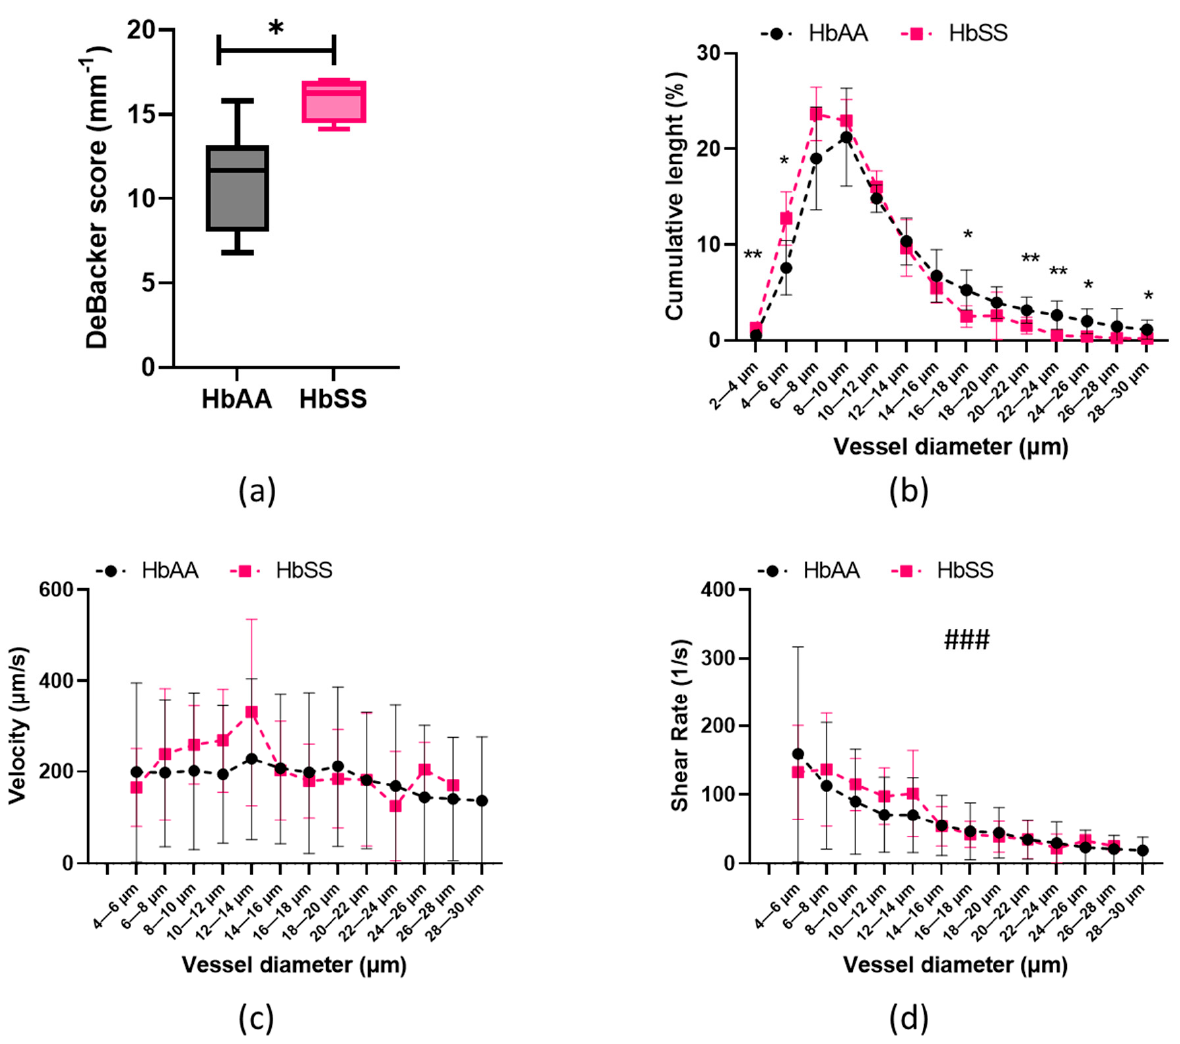
Figure 1. ( a ) De Backer score, ( b ) vessel diameter distribution in sublingual microcirculation, ( c ) velocity distribution within microcirculation, ( d ) and shear rate distribution within microcirculation for HbAA and HbSS groups. Significant differences between HbSS with HbAA groups: * represents p < 0.05, and ** represents p < 0.01. Significant decrease across the vessel diameters: ### represents p < 0.001. No significant difference was found between HbSS group and HbAA group, but a trend was observed of HbSS group having slightly higher shear rates ( p = 0.054).